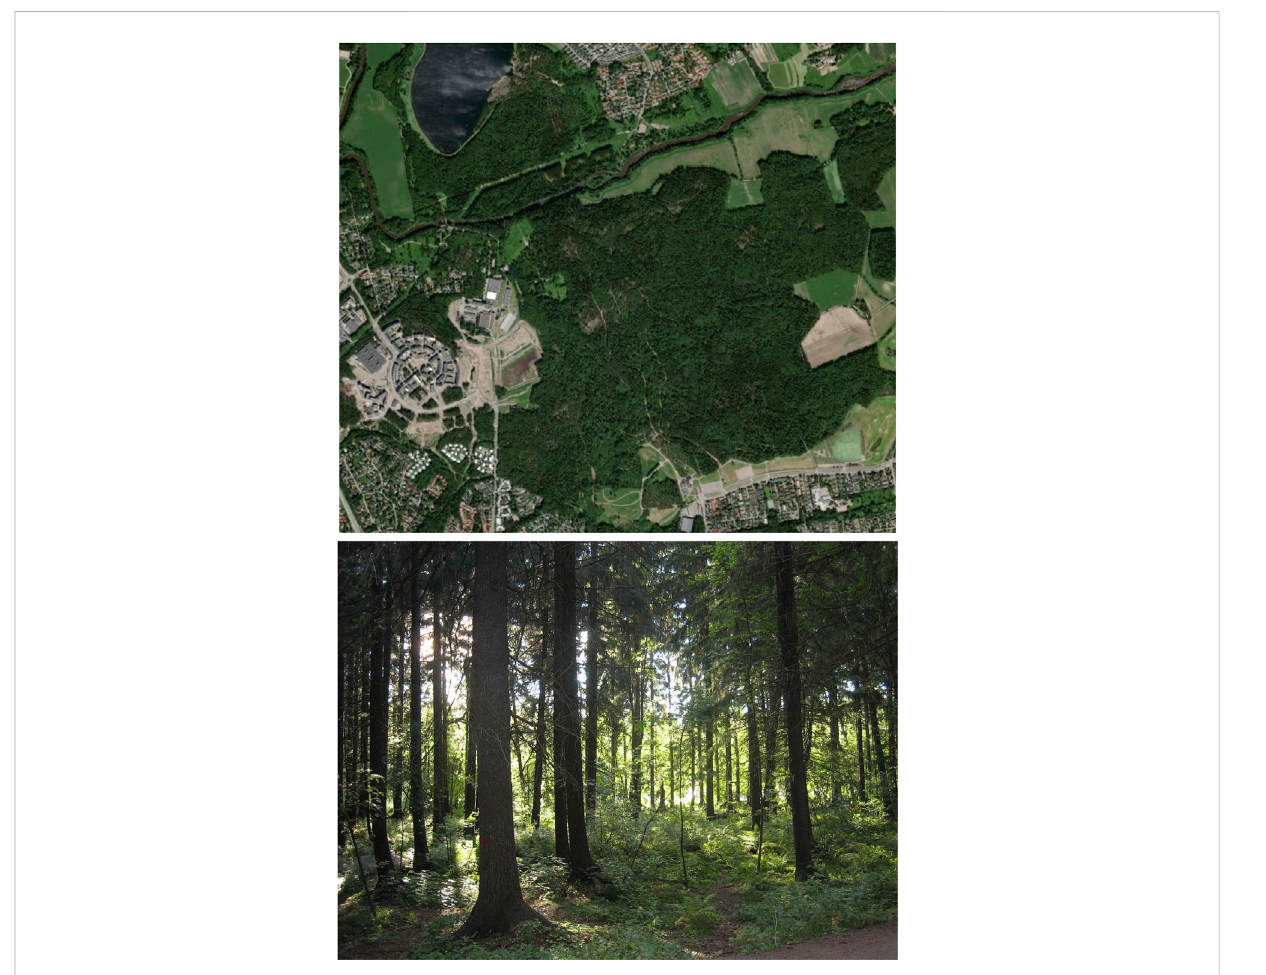
FIGURE 12 Multi-affordance greenspace characteristics. Paloheina Woodland. Orthophoto Top — BingMaps (2022). Photo bottom —